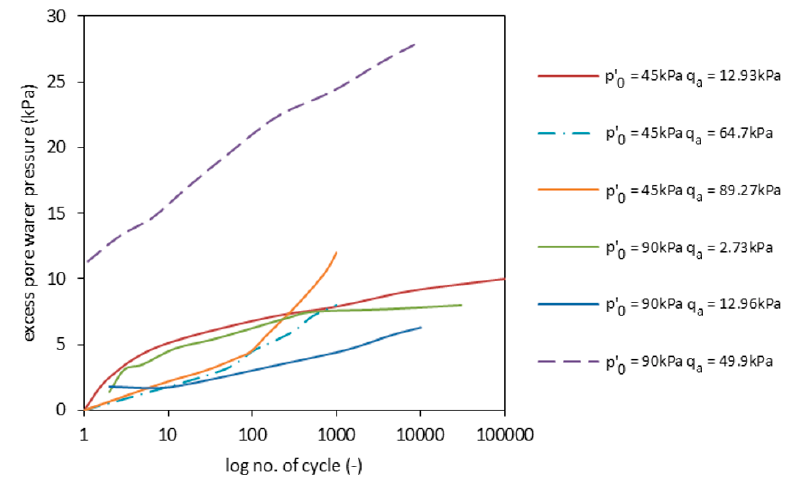
Figure 8. Excess pore pressure generation during the three tests for the RCA sample.